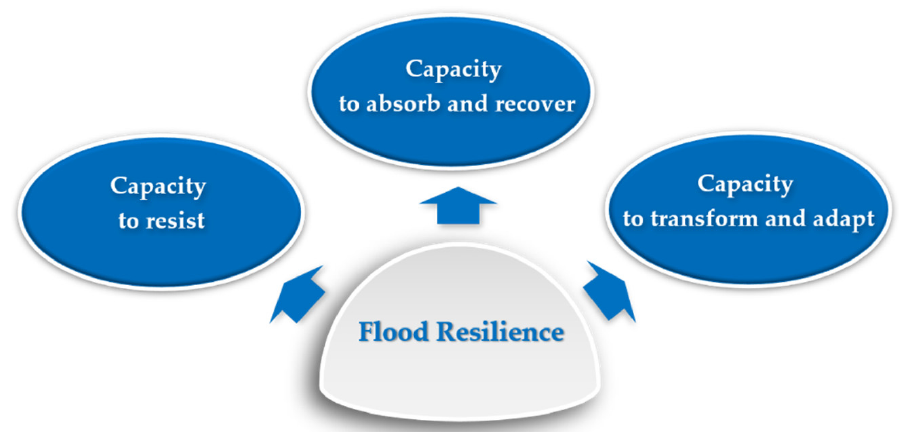
Figure 6. Flood resilience as a result of multiple complementary capacities.